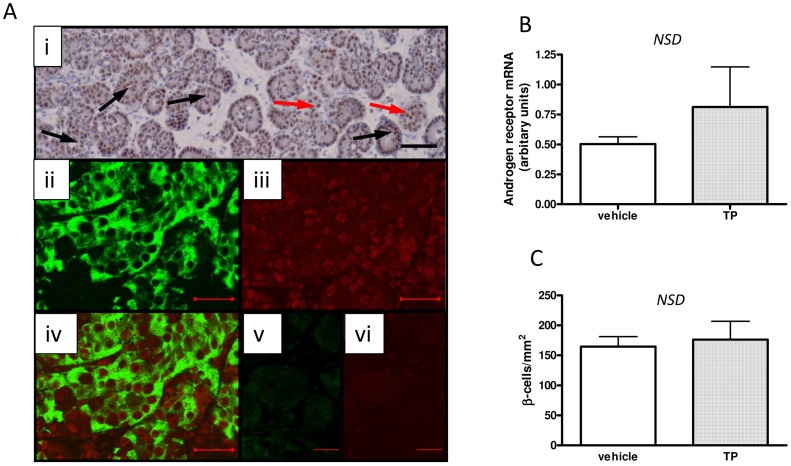
Ovine fetal pancreatic androgen receptor localization, AR expression and β-cell content.Panel A: (i) Fetal pancreas showing nuclear AR protein (brown) in multiple cell types including glandular tissue (black arrows) and presumed islets (red arrows). (ii) Fluorescent immunohistochemical staining for insulin (green) in a (vehicle) d90 fetal pancreas. (iii) Fluorescent immunohistochemical staining for AR (red) in a (vehicle) d90 fetal pancreas and (iv) represents a dual merge of insulin (green) and AR (red) confirming that β-cells express AR. (v) and (vi) show negative controls for insulin and androgen receptor respectively. Scale bar is 100 µm (i) and 25 µm (ii–vi). MI-TP had no effect on either AR abundance (n = 5, n = 8, vehicle and TP fetuses respectively) (Panel B) or fetal β-cell numbers (Panel C).